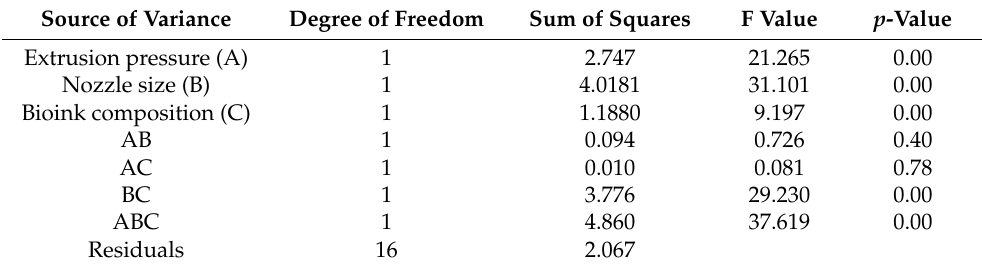
Table 5. ANOVA Table for effects on perimeter deviation (shape